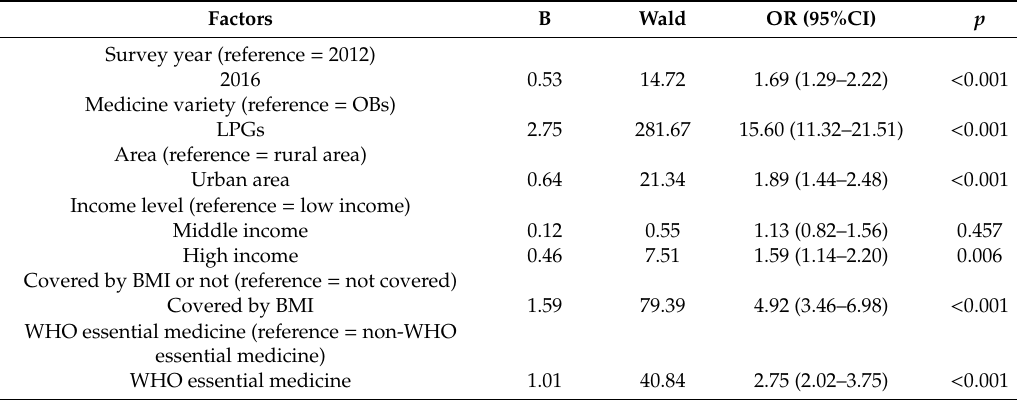
Table 9. Factors associated with the a ff ordability of anticancer